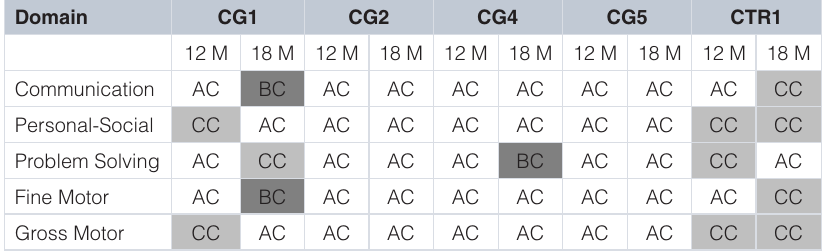
Table 2. Ages and Stages Questionnaires- 3 (ASQ3) scores for ages 12 and 18